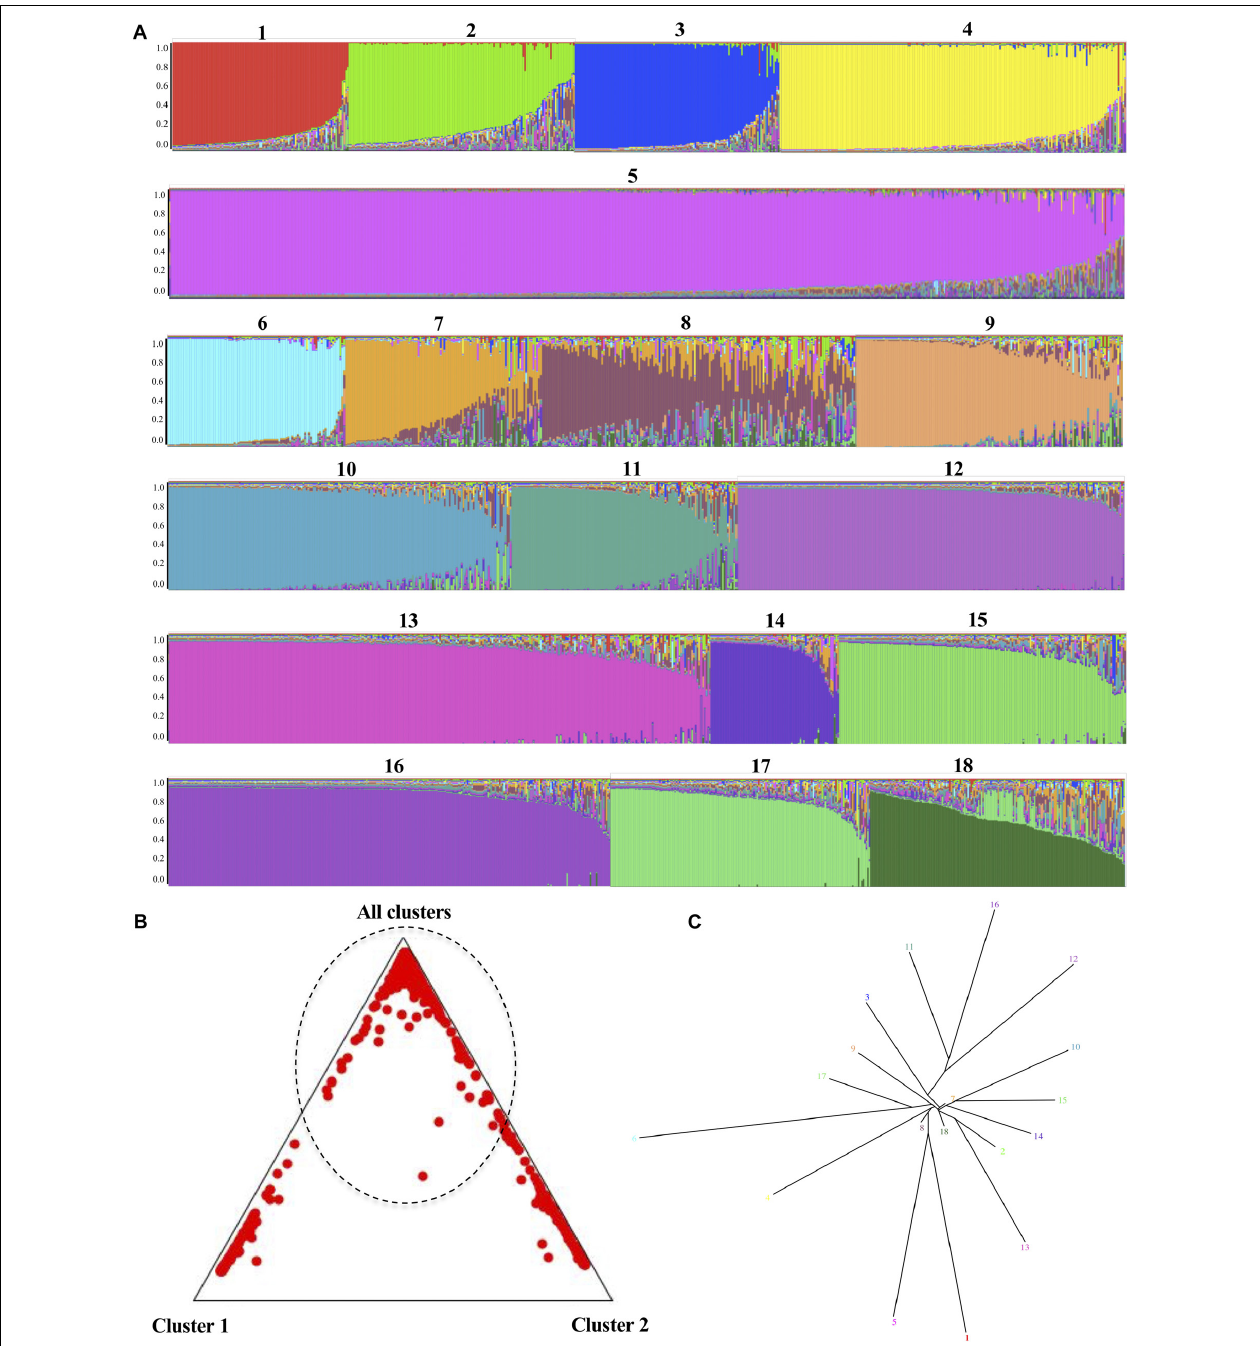
FIGURE 5 | Identification of genetic admixture signals in C. albicans using STRUCTURE software 2.3.4 (Hubisz et al., 2009). The analysis parameters under consideration were the number of clades previously described for this species, which is included as the number of populations ( K = 18), together with 600,000 iterations of the Markov chain Monte Carlo algorithm following a burn-in of 60,000 iterations. (A) Bar plot sorted by Q for K = 18. The presence of more than one color in each bar represents genetic admixture signals. (B) Triangle plot that shows the distribution of the DSTs in clusters; that is, either 1, 2 or all others, the latter category including all those whose probability of grouping cannot be defined. (C) Tree plot representing the genetic distance between the K structure